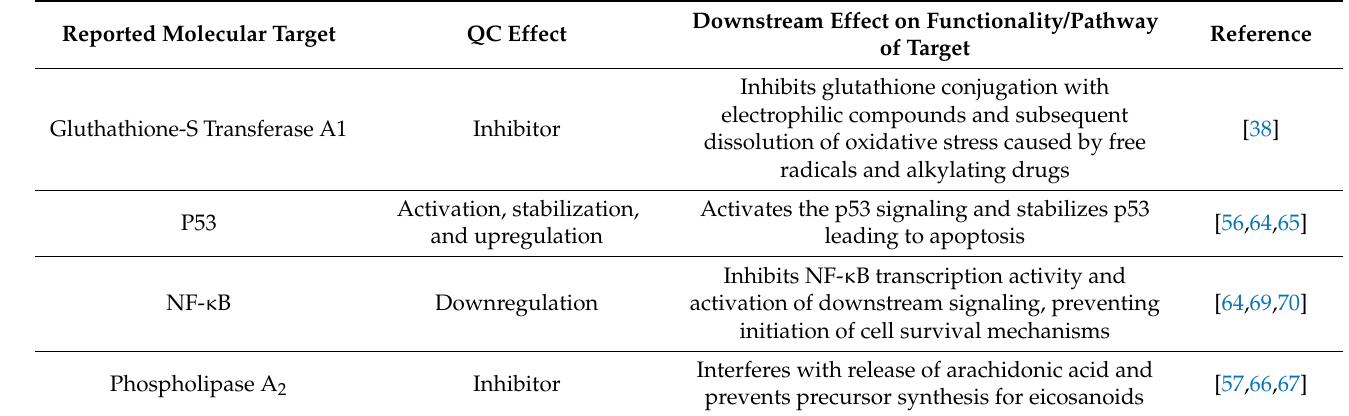
Table 2. Table demonstrating the reported molecular targets of QC and its downstream effect on cellular cascades. Molecular targets of Quinacrine (QC) impacting cancer